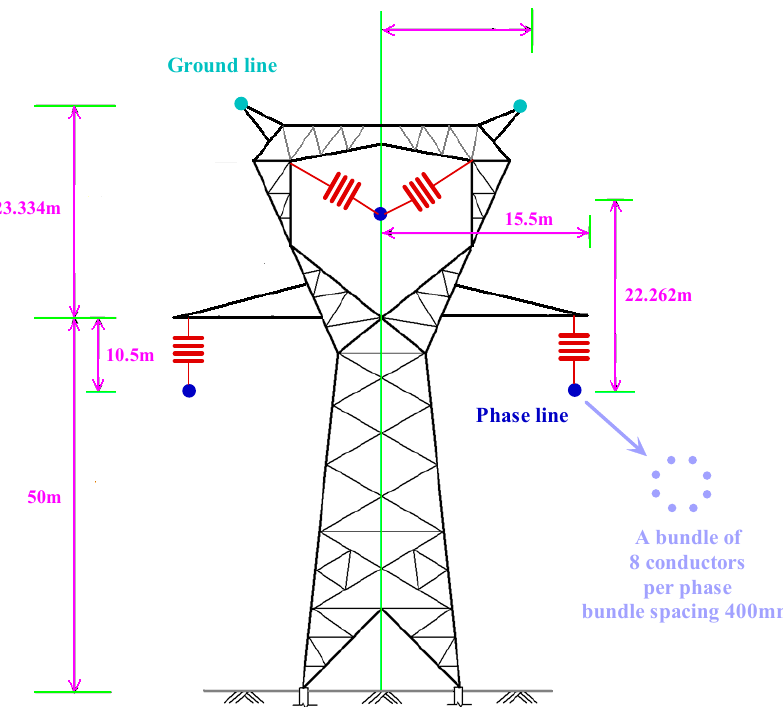
Figure 3. A 1000 kV transmission tower.